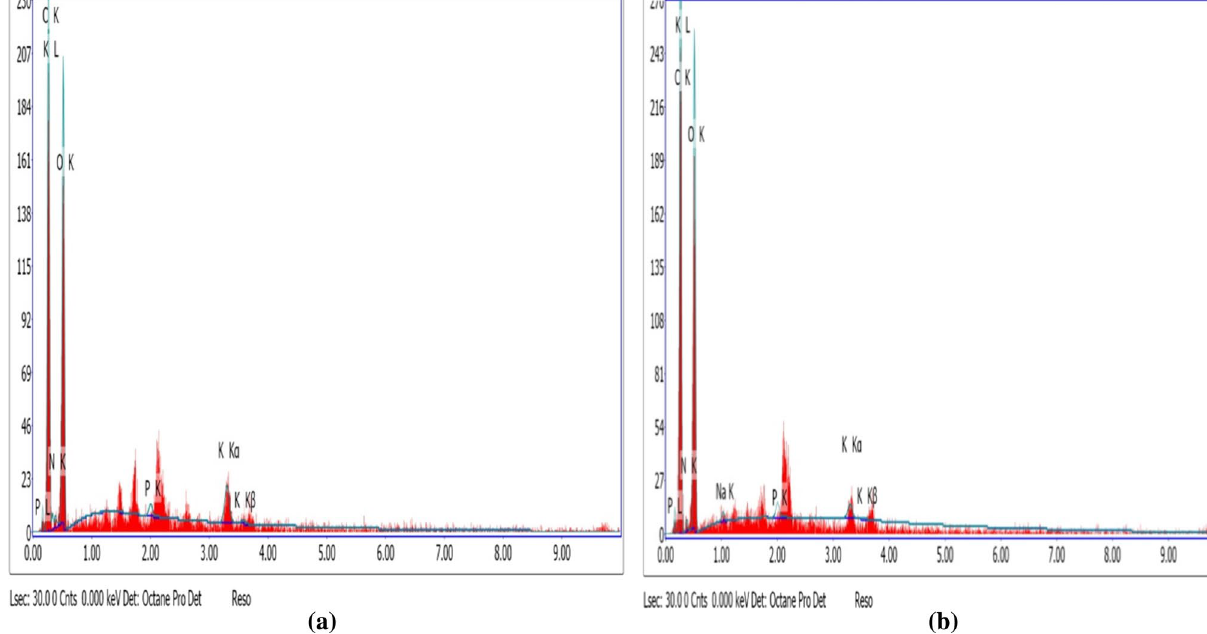
Fig. 7 a EDX analysis of Eichhornia crassipes roots unloaded with phenol and cyanide and b loaded with phenol and